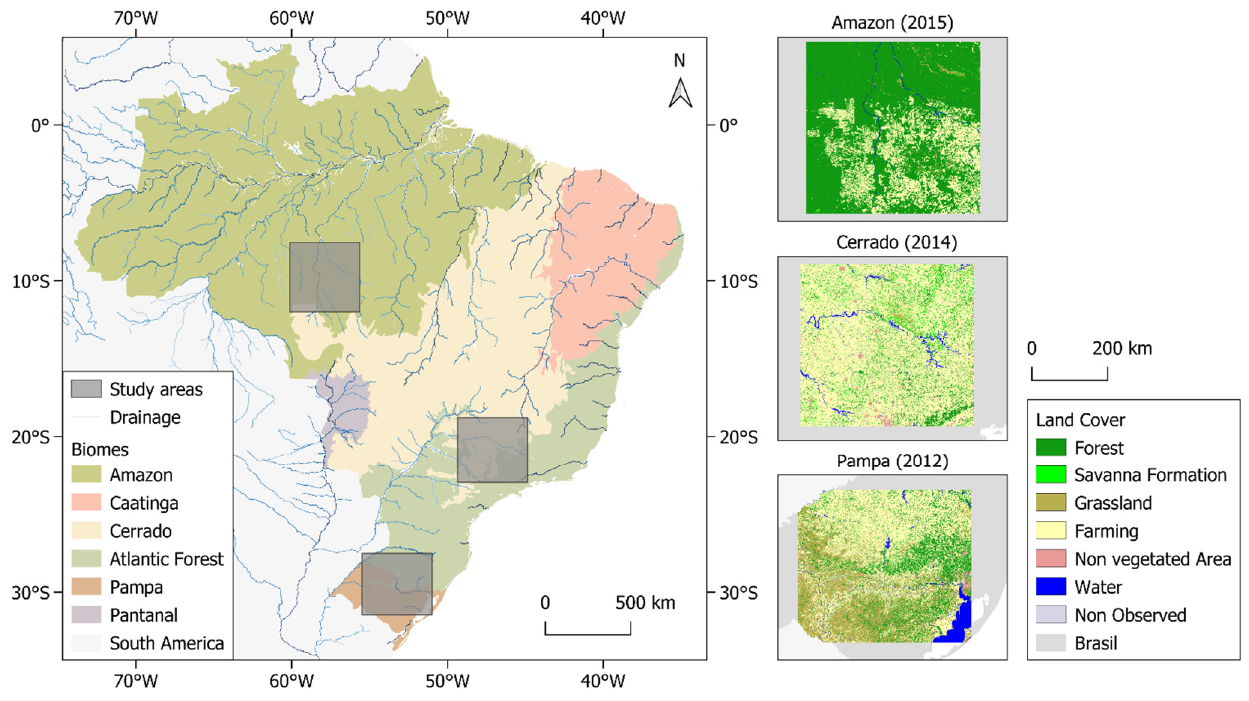
Figure 1. Brazilian biomes and land cover in the study areas. Land cover from MapBiomas [61].